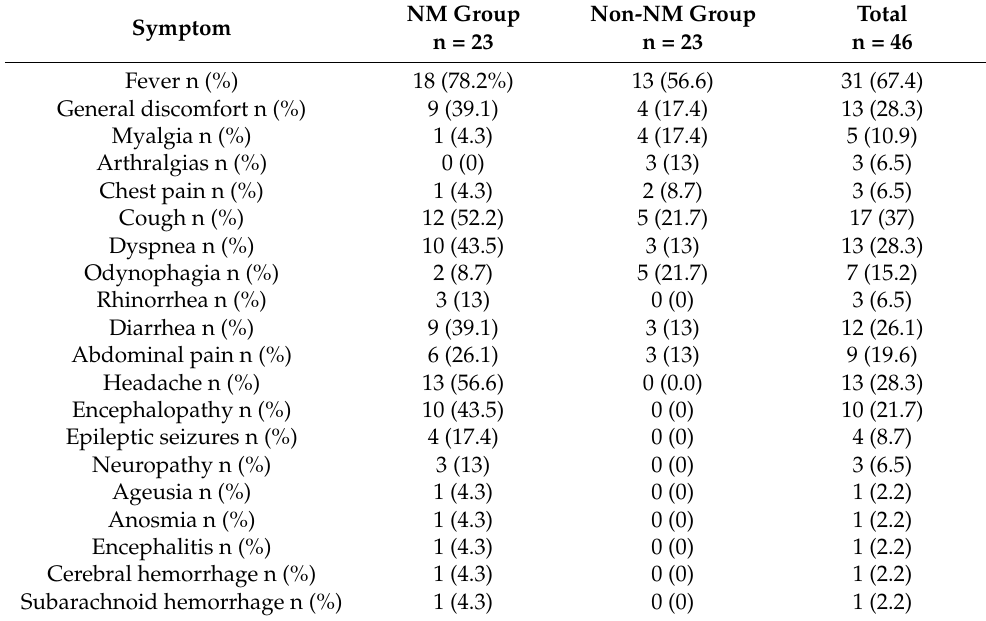
Table 3. Clinical manifestations in pediatric patients with